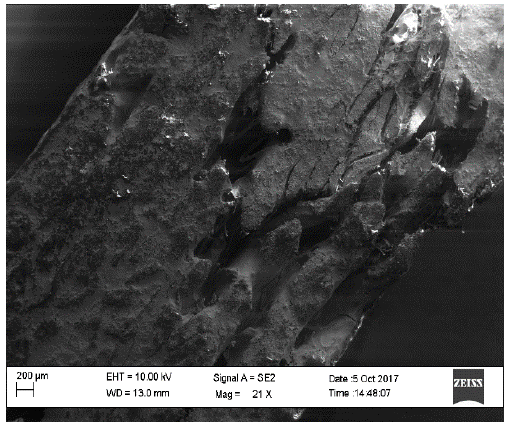
Figure 10. Visualization of the breaking of the outer folds.